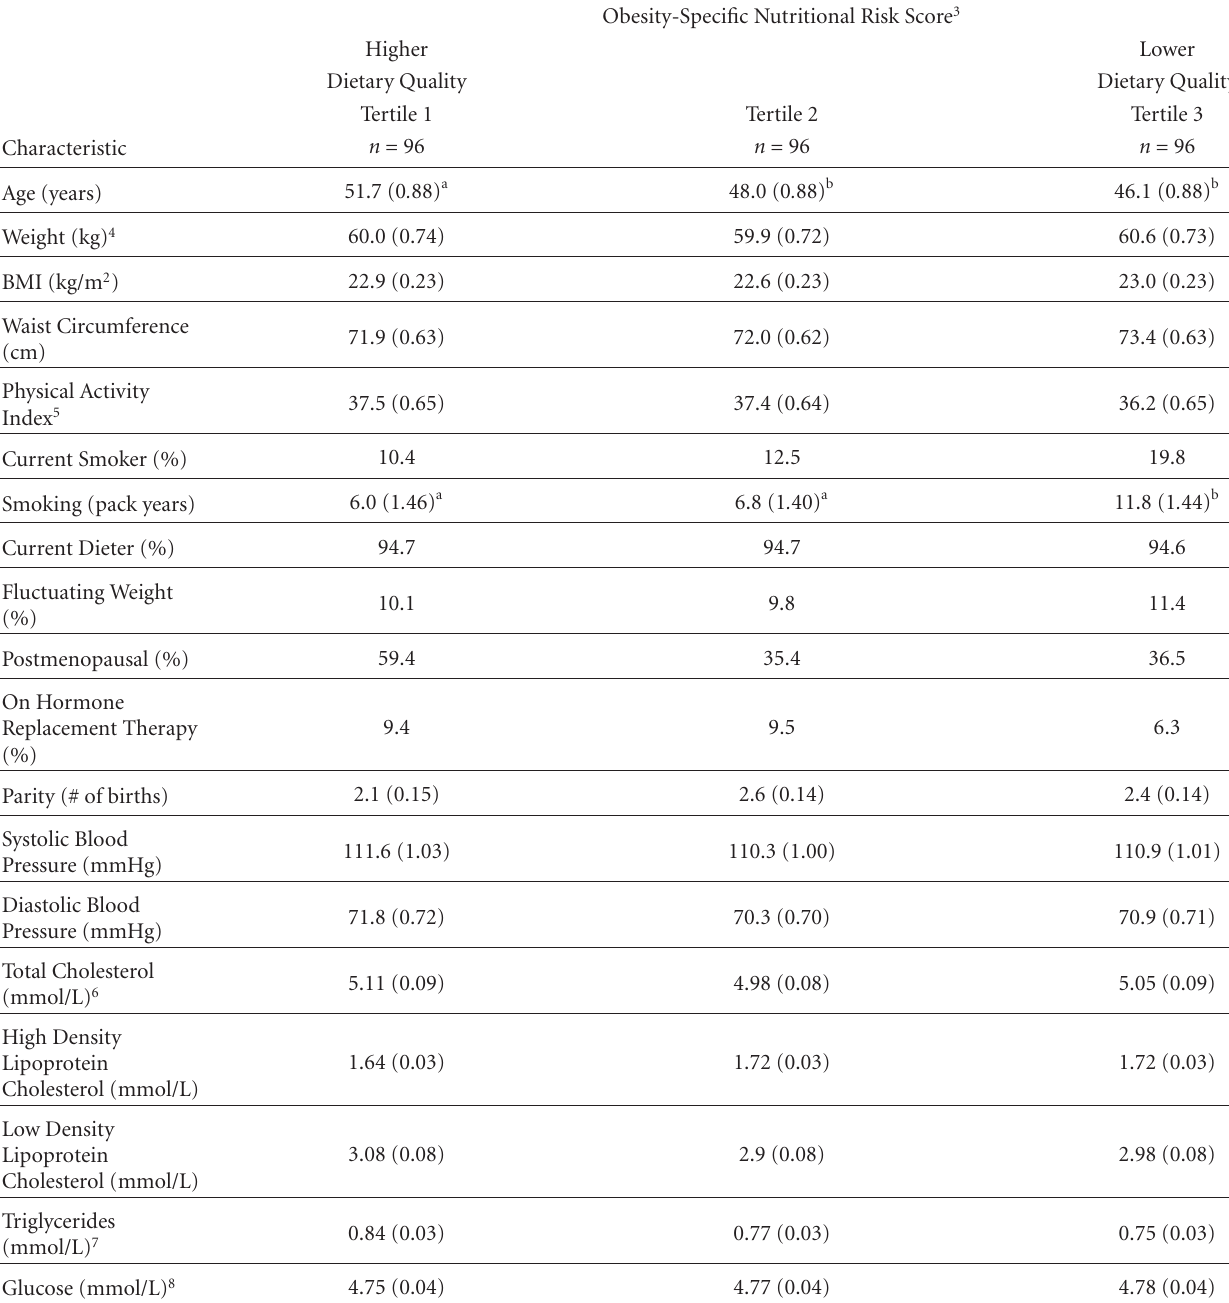
Table 1: Baseline characteristics of 288 healthy women without abdominal obesity (waist circumference ≤ 88 cm) in the Framingham O ff spring-Spouse Study according to dietary quality 1,2